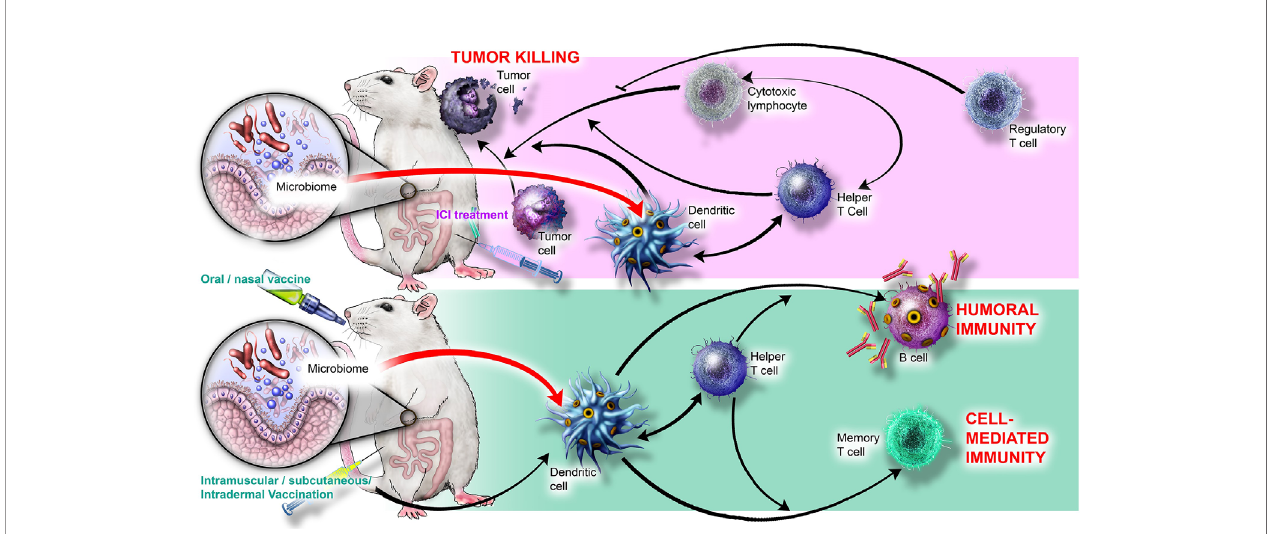
FIGURE 1 | Cellular players and interactions involved in immune checkpoint inhibitor-mediated tumor killing and vaccine-induced immunity. (Top) ICIs stimulate cytotoxic lymphocytes, Th1 helper T cells, and DCs to kill tumor cells; Tregs inhibit killing. MAMPs produced by bacteria such as B. thetaiotaomicron and B. fragilis may interact with TLR2 and TLR4 on DCs and stimulate Th1 polarization and synergize with ICI activity. Microbial metabolites such as inosine (produced by B. pseudolongum) may also contribute to ICI ef fi cacy by stimulating T cell proliferation. (Bottom) Live, inactivated, or molecular vaccination ultimately activates DCs and helper T cells to yield humoral immunity (B cell antibodies) and cell-mediated immunity (memory T cells). MAMPs, such as fl agellin and peptidoglycan, interact with PRRs to stimulate B cells and Tfh cells, thereby augmenting vaccine response. Microbially produced SCFAs may also stimulate